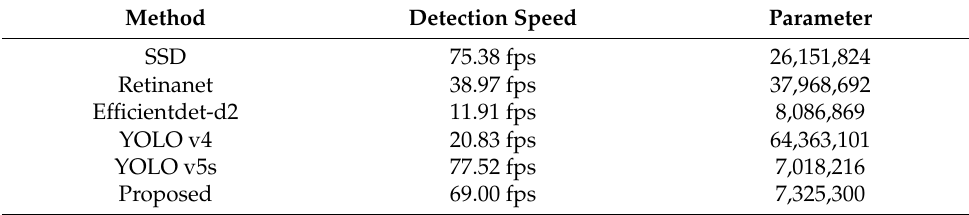
Table 5. Result of detecting speed of smoke picture and parameter of models.